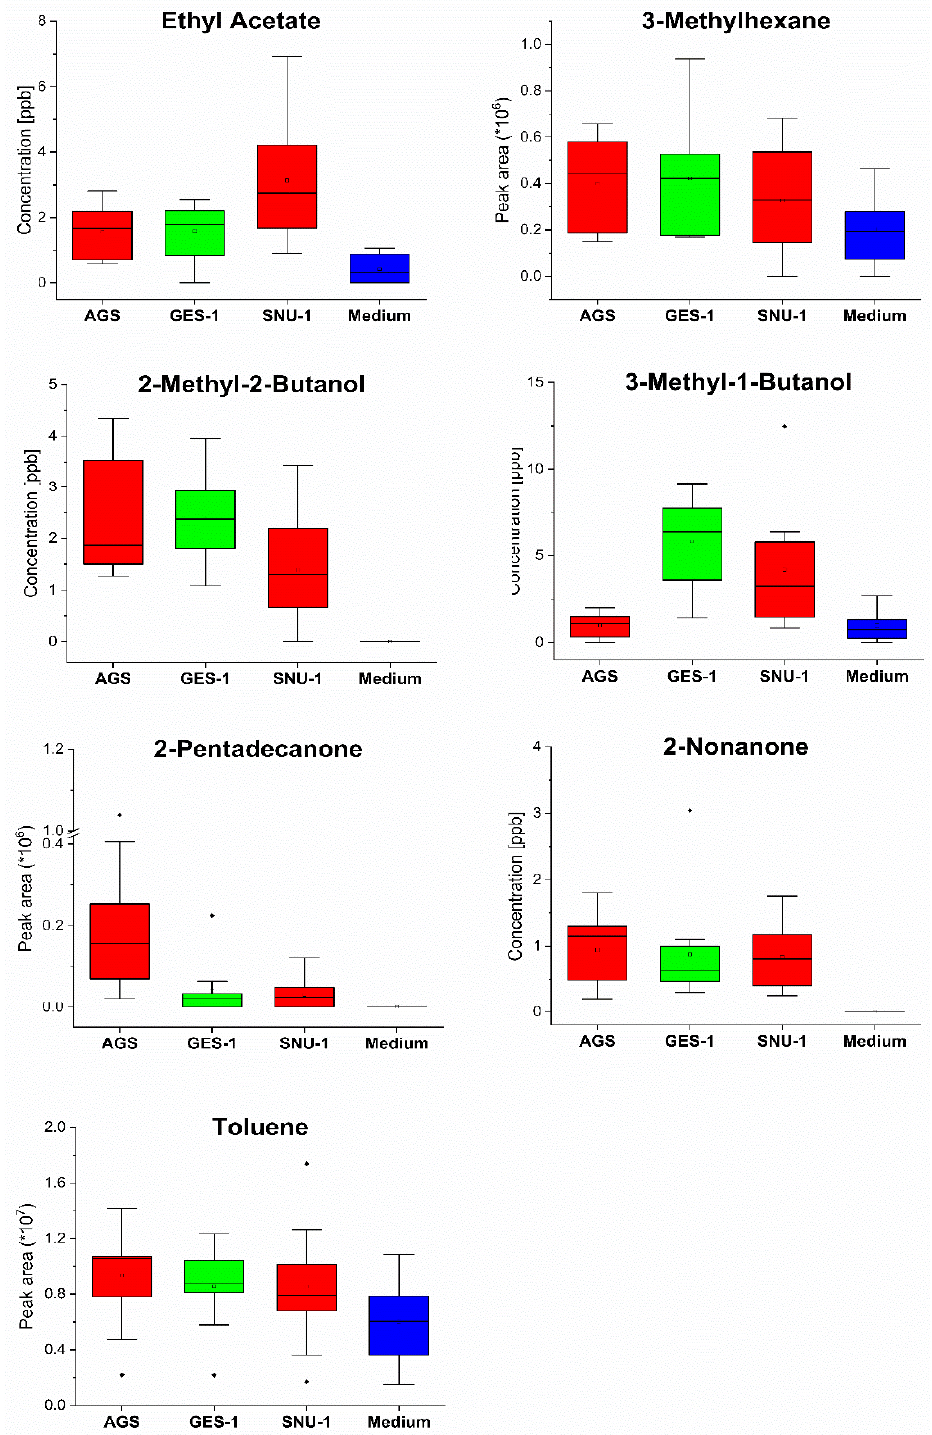
Figure 2. Comparison of the headspace concentrations of selected released VOCs over the cultures of AGS, SNU-1, GES-1 cells and medium. Red—cancer cells, green—normal cells, blue—medium.